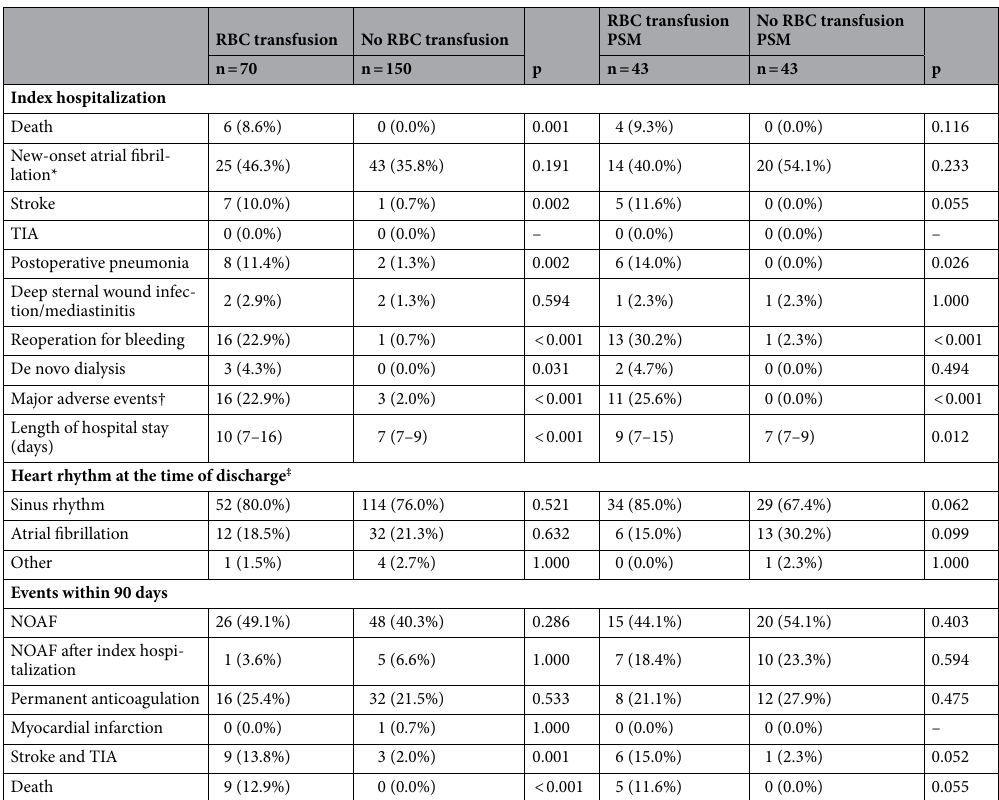
Table 3. Clinical outcomes. Continuous variables are reported as median and interquartile range or mean and standard deviation. Categorical variables are reported as counts and percentages. NOAF New-onset atrial fibrillation, TIA transient ischemic attack. *Patients with preoperative atrial fibrillation or atrial flutter (n = 60) were excluded from the variable. † Major adverse event includes stroke, TIA, postoperative pneumonia and death during index hospitalization. ‡ Other: pacemaker or junctional